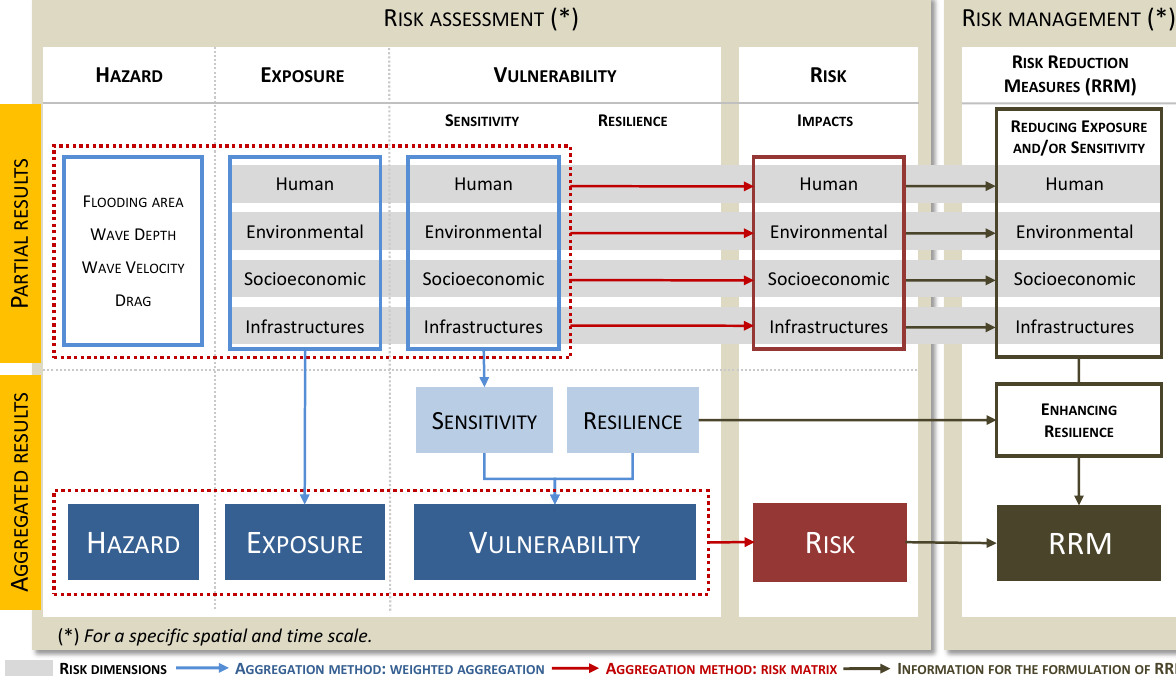
A GGREGATION METHOD : RISK MATRIX I NFORMATION FOR THE FORMULATION OF RRM A GGREGATION METHOD : WEIGHTED AGGREGATION R ISK DIMENSIONS